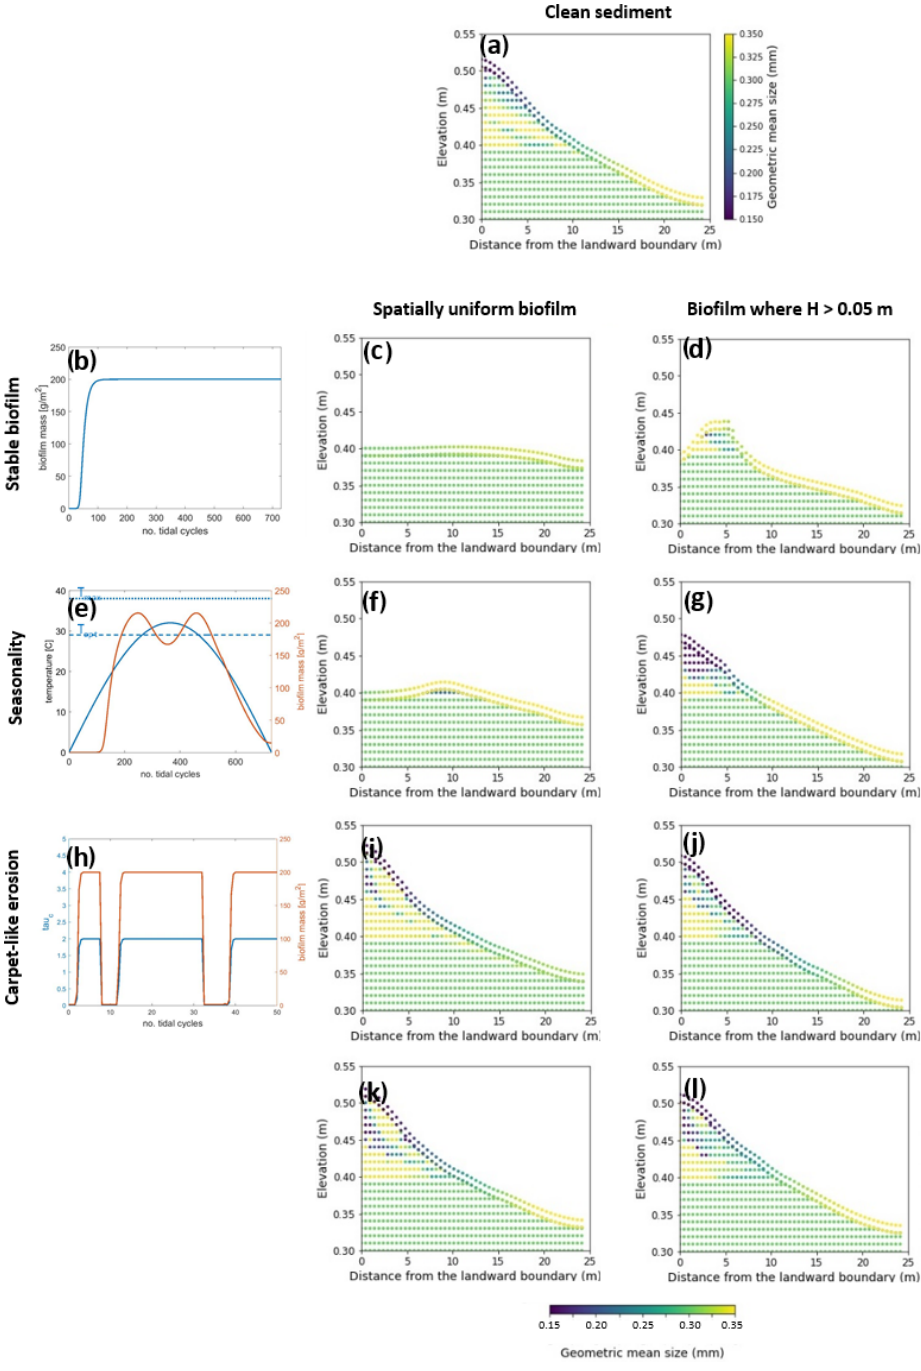
Figure A3. Final stratigraphy of the deposit after 30000 simulated tidal cycles under different biofilm conditions. Panel (a) shows the stratigraphy of the deposit in the reference case with clean sediment. The panels in the left column represent the time evolution of biofilm during the simulation, showing stable biofilm (b) and the effect of seasonality (e) and carpet-like erosion (h) . The rows represent, respectively, the stratigraphy of the deposit under these biofilm conditions. The panels in the central column show the stratigraphy of the deposit in the case of biofilm that is uniformly distributed spatially. The panels in the right column show the stratigraphy of the deposit in the case of biofilm that has developed only in locations where the water depth is smaller than 0.05m. The initial geometric mean size of the sediment at the bed is